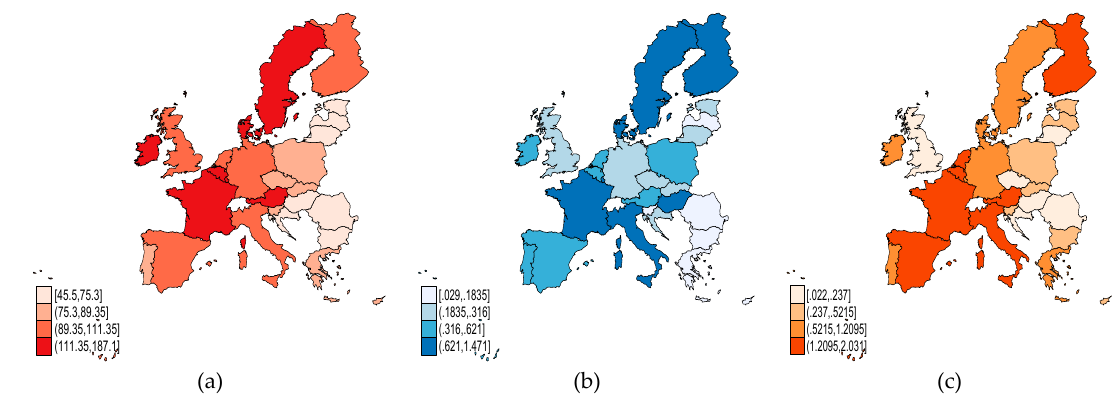
Figure 3. Labor market-specific indicators, EU-28, 2017: ( a ) Labor productivity ( LP ); ( b ) active labor market policies ( ALMP) ; ( c ) passive labor market policies (PLMP). Source: Own process in Stata. For a suitable comparison between EU countries and to manage the stationarity of the indicators, firstly, the dataset was processed through the logarithm procedure. Then, the methodology used consisted of structural equation modeling (SEM), which was applied for the two distinctive panels, EU-13 and EU-15. SEM represents an integrative procedure that appraises overall interlinkages among considered variables, direct, indirect, and total. SEM models are configured through the general system of Equation (1).